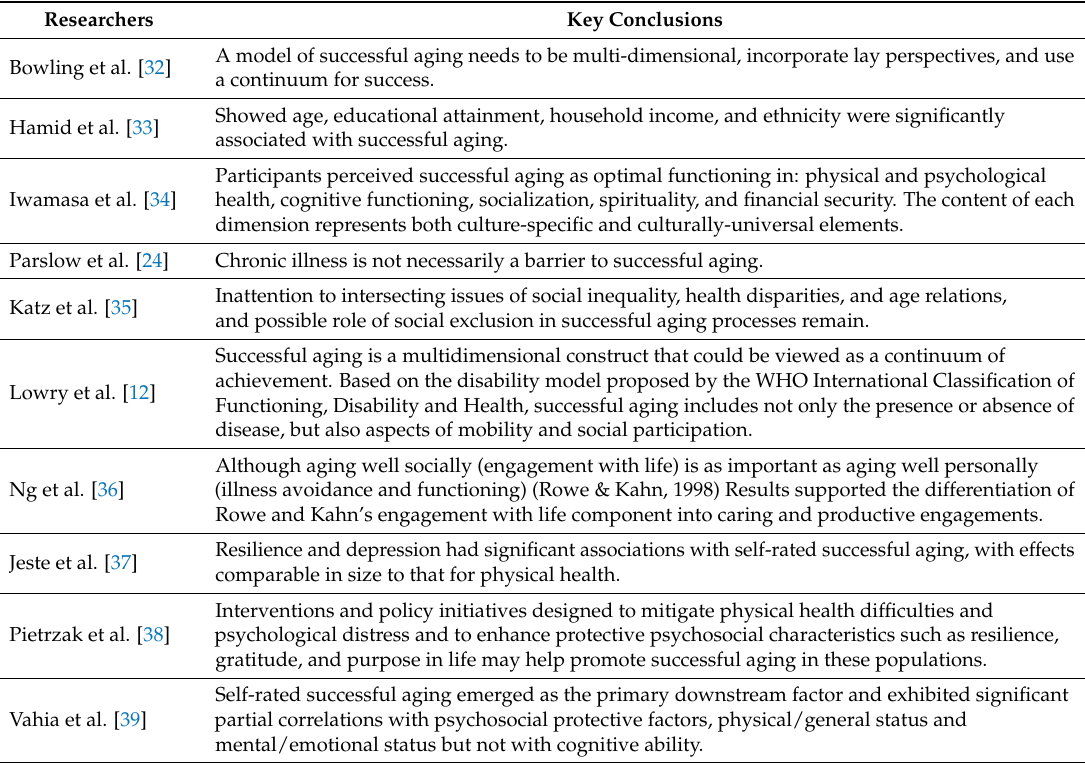
Table 1. Selected successful aging studies and